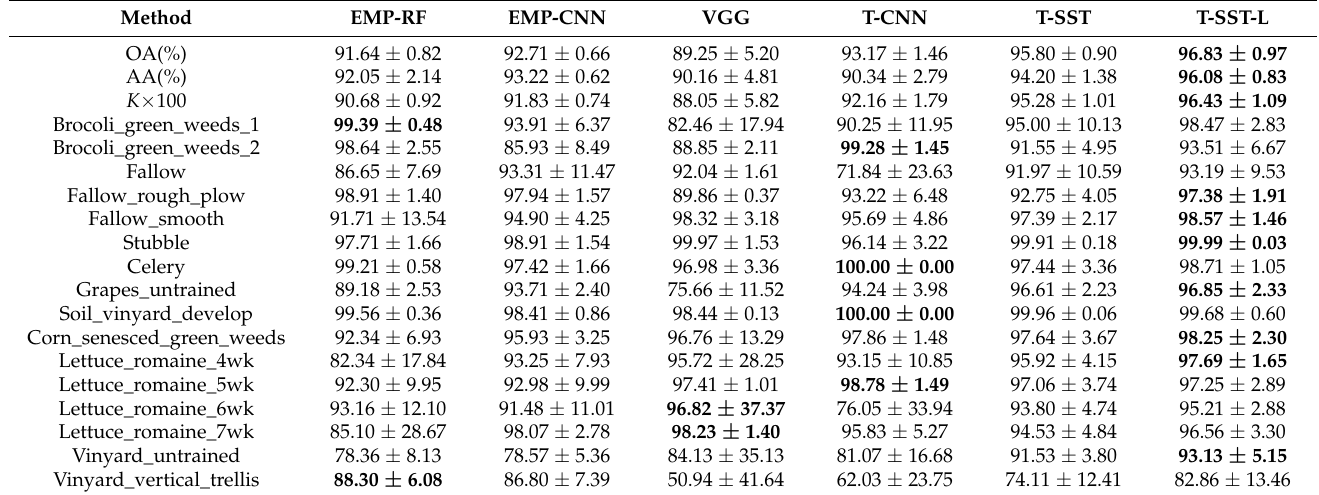
Table 5. Test accuracy with different preprocessing methods on the Salinas dataset.